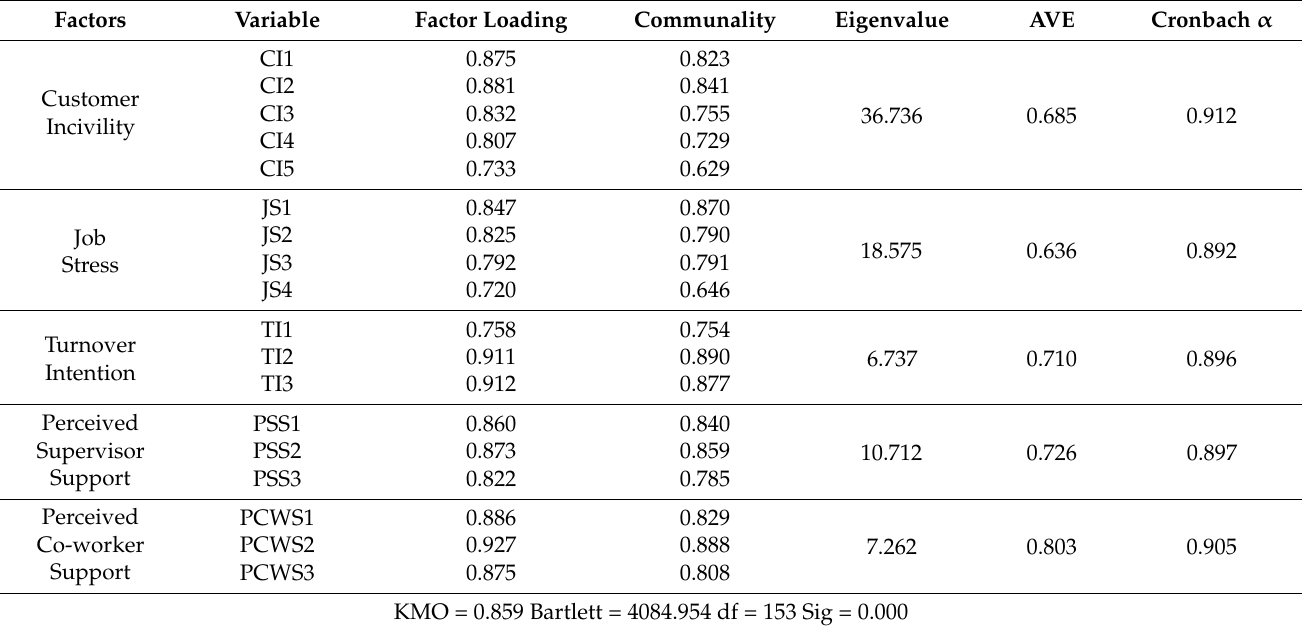
Table 2. Results of the factor and reliability analyses.